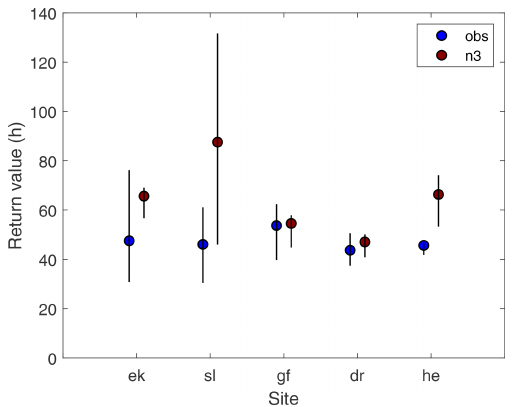
Figure 11. The 25-year return value with the corresponding con- fidence interval of the maximum duration of a zero event gener- ated by fitting a generalized Pareto distribution to the POT (peak over threshold) data using both observations (obs) and modeled data (n3) for each of the sites. Abbreviations: ek: Ekofisk; sl: Sleip- ner; gf: Gullfaks C; dr: Draugen; he: